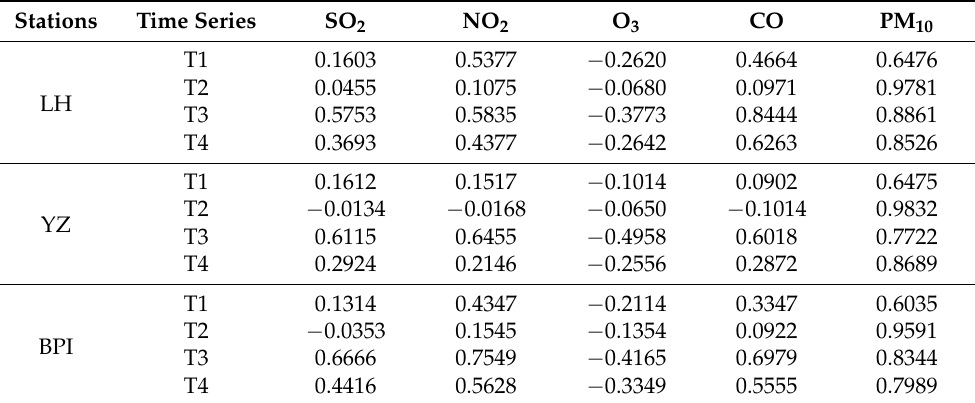
Table 3. Pearson correlation coefficient r between PM 2.5 and the other five pollutants in the short- /long-term time